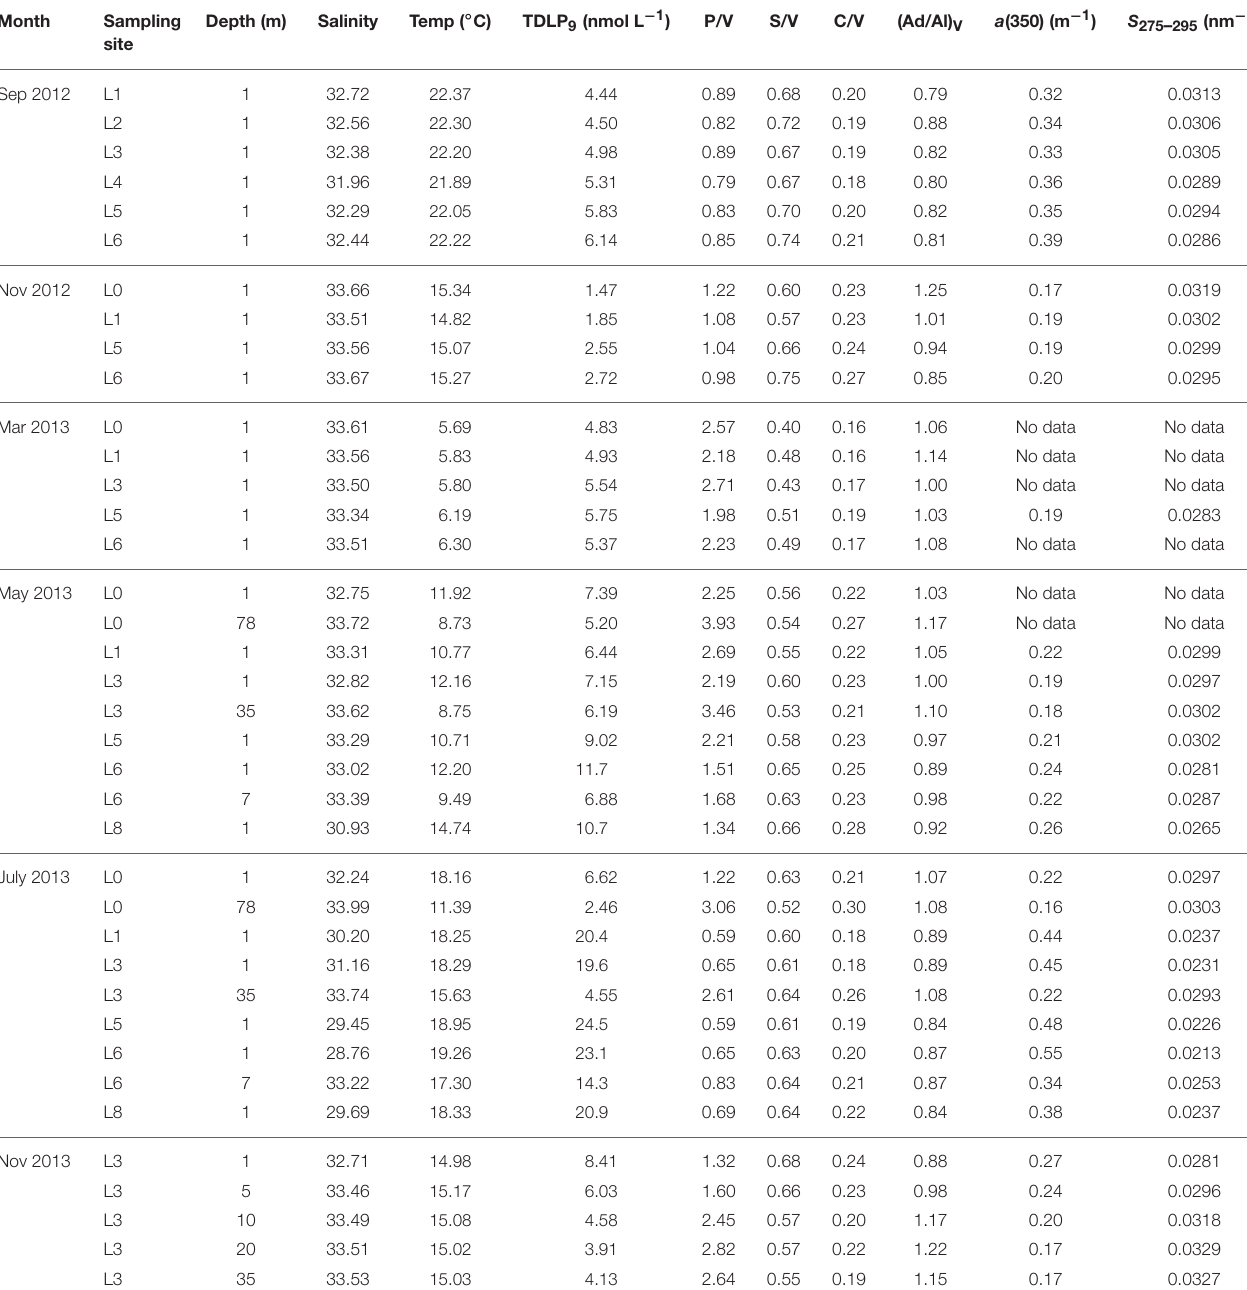
TABLE 2 | Dissolved lignin phenol concentrations (TDLP 9 ), composition ratios [P/V, S/V, C/V, and (Ad/Al) V ], and CDOM parameters [ a (350) and S 275 – 295 ] in Otsuchi Bay. Month Sampling